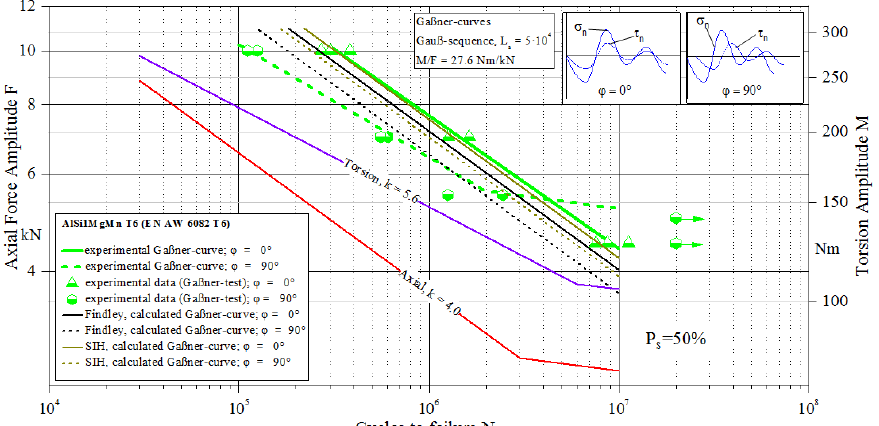
Figure 8: Experimental and computational Gassner-lines for aluminum alloy EN AW 6082 T6 with the application of non- proportionality factors.